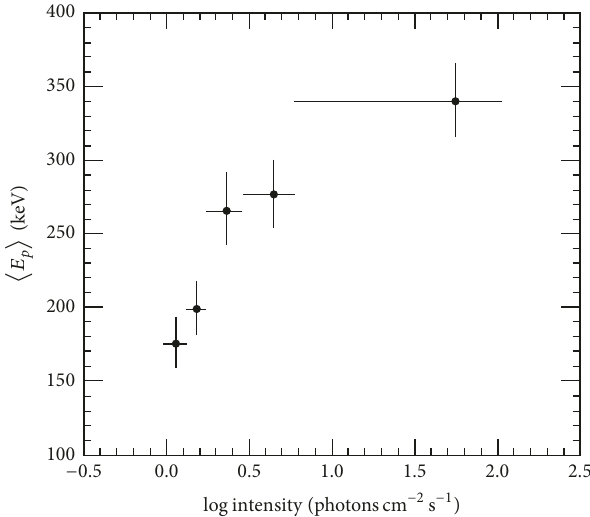
Figure 6: The average ] 𝐹 ] peak energies as a function of intensity for five groups of GRB spectra. The vertical bars represent 1𝜎 estimated error in the mean, where the peak energy distributions were assumed to be approximately Gaussian in logarithm of energy. The horizontal bars mark the bin widths. (Figure after Mallozzi et al. [110]; see Figure 2 therein. @ AAS. Reproduced with